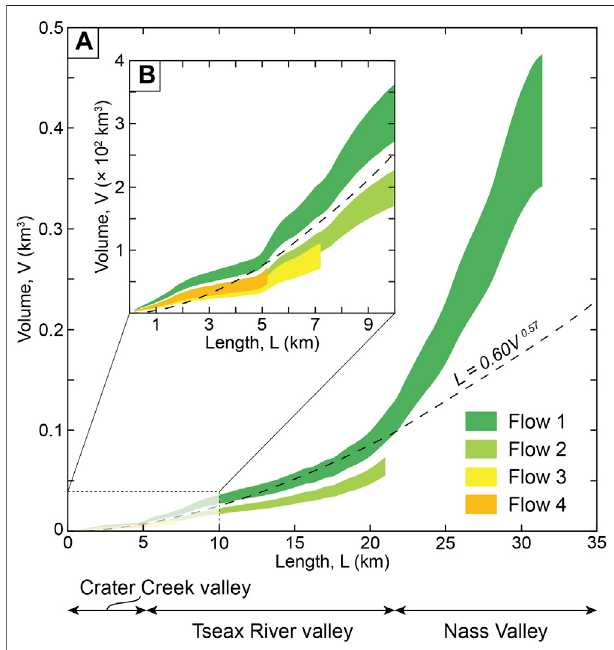
FIGURE11| Length-volumerelationshipofthefourTseaxlava fl ows. (A) Length-volume relationship along the entire fl ow fi eld. Dashed line is the Pinkerton and Wilson (1994) model. (B) Zoom on the fi rst 10 km of the Tseax lava fl ow fi eld. Note that the four fl ows closely follow the model along the narrow V-shaped Crater Creek and Tseax River valleys. In the Nass Valley, Flow 1 departs from the model due to widening of the lava.